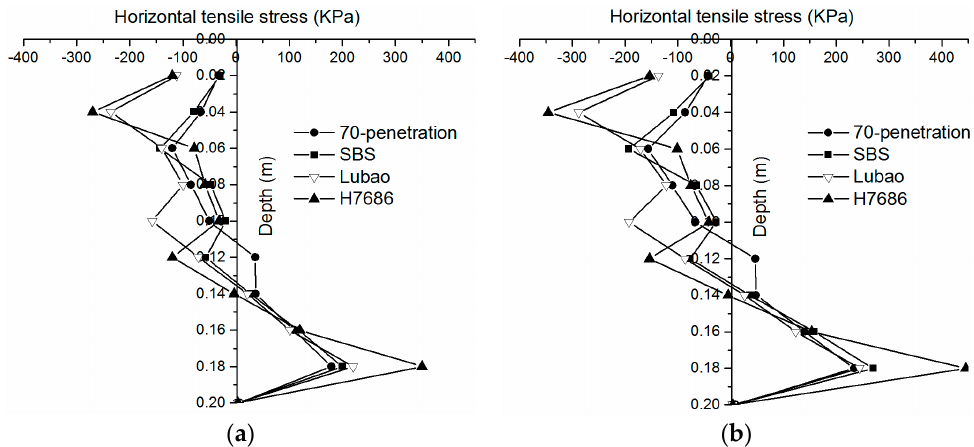
Figure 9. Horizontal longitudinal tensile stresses at the bottom center of underlayers: ( a ) under standard load; ( b ) under heavy load.